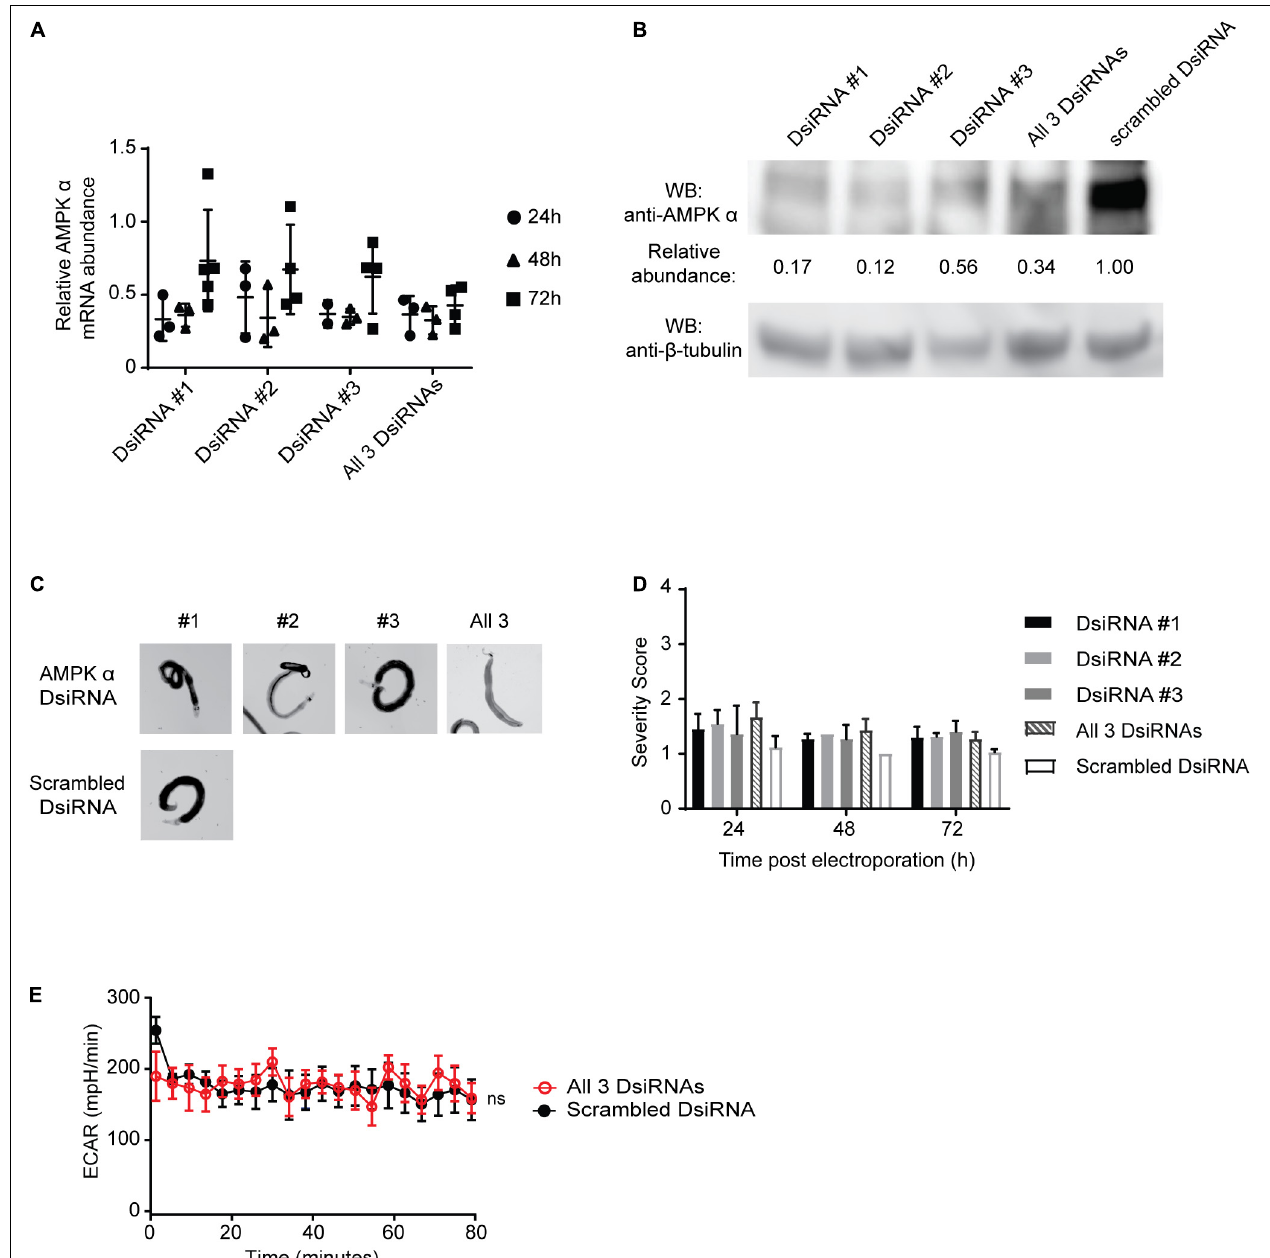
FIGURE 5 | RNAi knockdown of AMPK α in adult schistosomes. (A) RNAi was performed on freshly isolated adult schistosomes by electroporation in the presence of three S. mansoni AMPK α -targeting DsiRNA constructs, either separately (DsiRNA #1, DsiRNA #2, and DsiRNA #3), or in combination (all three DsiRNAs). Control parasites were electroporated with a scrambled DsiRNA control construct. AMPK α transcripts were quantified at 24, 48, and 72 h post-RNAi using quantitative real-time RT-PCR. AMPK α transcript abundance relative to the scrambled DsiRNA control were calculated. Data points represent independent biological replicates composed of 5–7 worm pairs. Bars represent mean ± standard deviation. (B) Lysates of adult schistosomes 72 h post-RNAi were prepared and equal amounts were probed by Western blot using anti-AMPK α and anti- β -tubulin antibodies. Protein abundance was determined by normalizing the anti-AMPK α signal to the anti- β -tubulin signal for each sample. Relative protein abundance compared to the scrambled DsiRNA samples was then calculated. WB indicates the antibodies used for Western blotting. Western blot pictured is representative of at least 3 biological replicates. (C) Representative adult schistosomes electroporated in the presence of either AMPK α -targeting DsiRNA #1, #2, #3, all 3 constructs combined, or scrambled DsiRNA were photographed 72 h post-RNAi. (D) DsiRNA-treated adult worms were phenotypically scored at 24, 48, and 72 h post-electroporation. Data shown are averages of at least 3 biological replicates. (E) The extracellular acidification rate (ECAR) of adult S. mansoni pairs 72 h post-electroporation with either all 3 AMPK α -targeting DsiRNAs or scrambled DsiRNAs were measured using Agilent Seahorse XFe96 system. Each data point is the average of at least 3 biological replicates. Data are representative of at least two independent experiments. ns P >